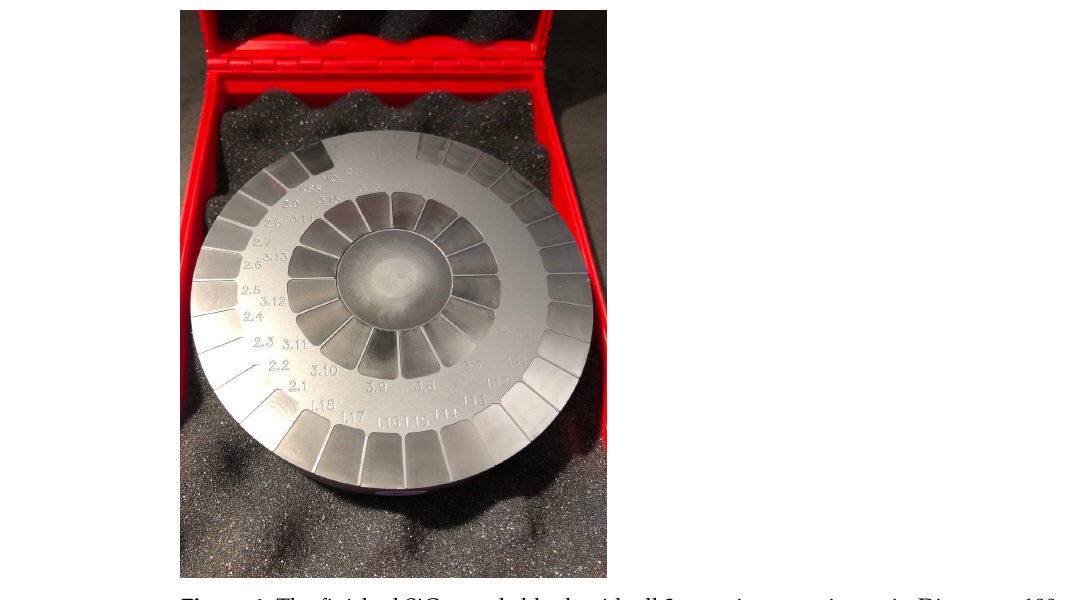
Figure 4. The finished SiC sample blank with all 3 experiment series on it. Diameter: 100 mm.